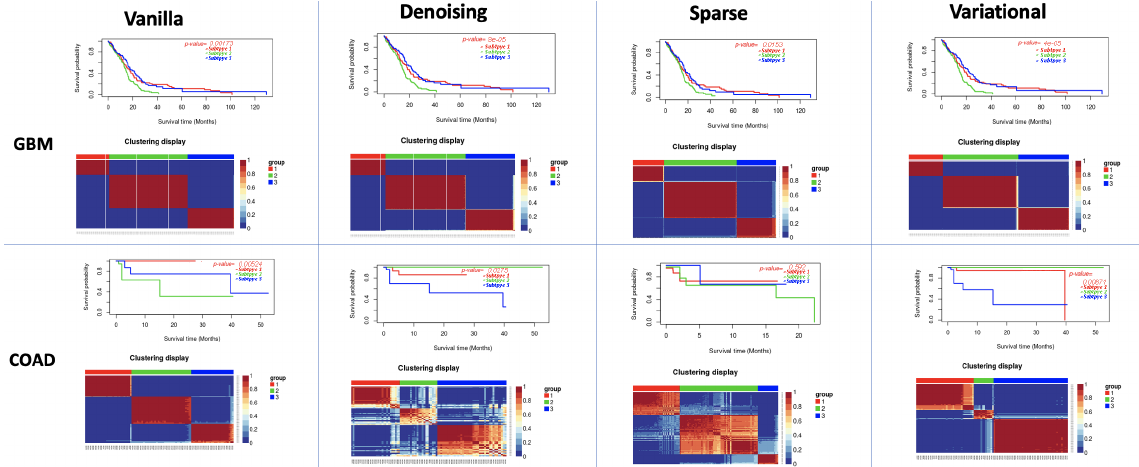
Figure 4. PAM survival analysis on Datasets. In each subfigure, ( Top ): Kaplan-Meier survival curves of three identified clusters; ( Down ): Patient to patient similarity and identified clusters on the